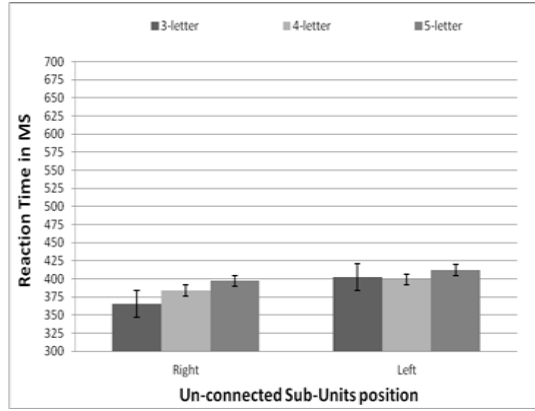
Figure 6. Reaction time as a function of uncon- nected sub-unit position (right, left) and word length (3, 4, 5 letters). Note: Error bars represent standard